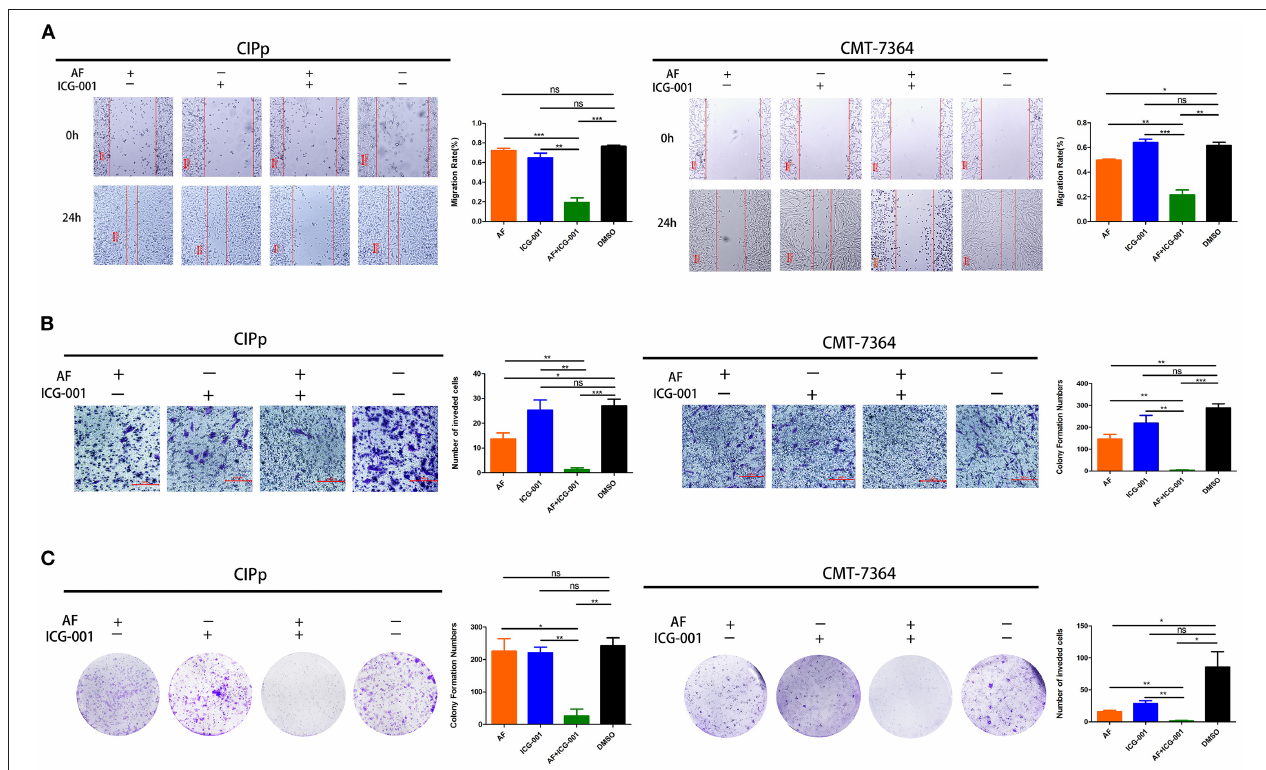
FIGURE 2 | Combination of AF and ICG-001 suppresses cell migration (A) , cell invasion (B) , and colony formation (C) of CIPp and CMT-7364 cell lines. Bar, 100 µ m (A) and 200 µ m (B) . Data were representative of three independent experiments. p -values: * p < 0.05; ** p < 0.01; *** p < 0.001; ns, non-significant.